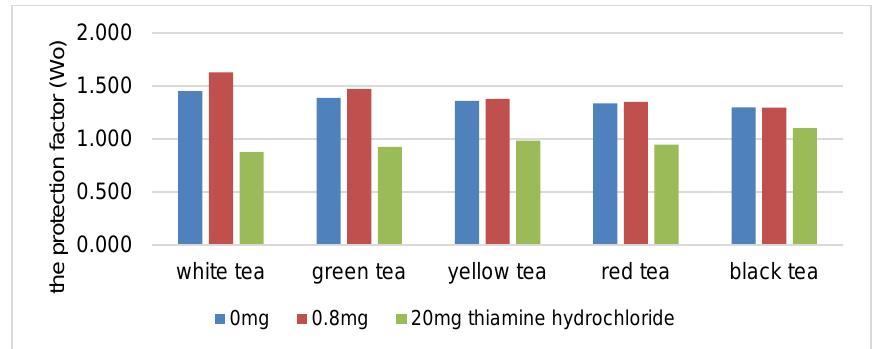
Antioxidants 2019 , 8 , x FOR PEER REVIEW Figure 1. The protection factor (Wo) of ethanol tea extracts in the presence of thiamine hydrochloride.